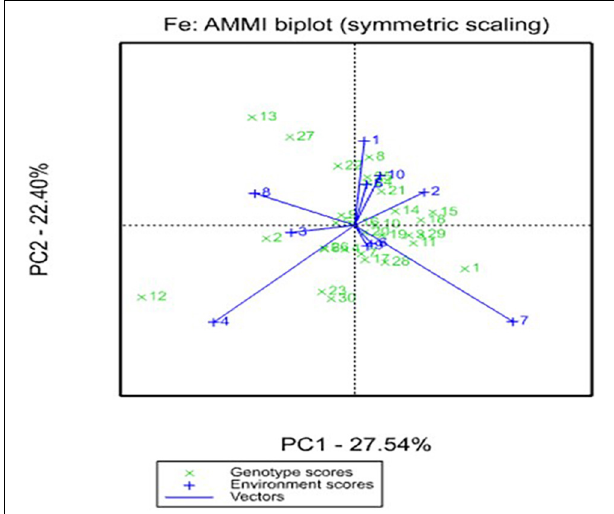
FIGURE 2 | Additive Main Effects and Multiplicative Interaction (AMMI) biplot for grain Fe content across environments in West and Central Africa. 1. AFRIBEH-NAARA, 2. AKAD-KOM, 3. CHAKTI, 4. Faringuero, 5. Gamoji, 6. GB 8735, 7. IBMV 8402, 8. ICMP 177001, 9. ICMP 177002, 10. ICMV 167005, 11. ICMV 167006, 12. ICMV 177001, 13. ICMV 177002, 14. ICMV 177003, 15. ICMV 177004, 16. ICMV 221, 17. ICMV 167001, 18. ICMV IS 85327, 19. ICMV IS 94222, 20. ICMV IS 99001, 21. ICTP 8203, 22. Jirani, 23. KAANATI, 24. LCIC 9702, 25. Moro, 26. Sadore Local, 27. SARIA-1, 28. SOSAT-C88, 29. Souna 3, 30.